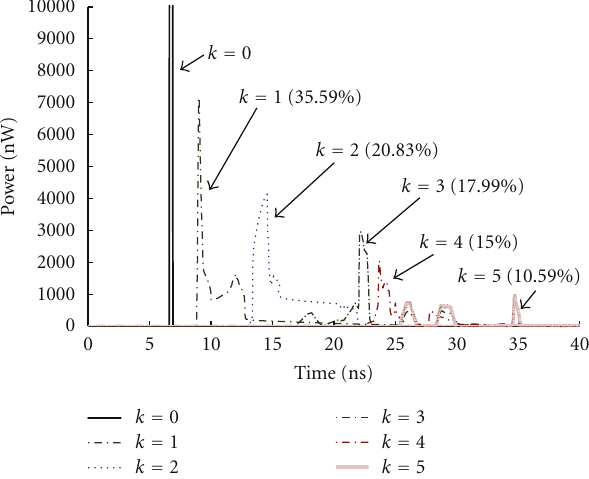
Figure 10: Impulse responses of configuration D for light undergo- ing up to five reflections.